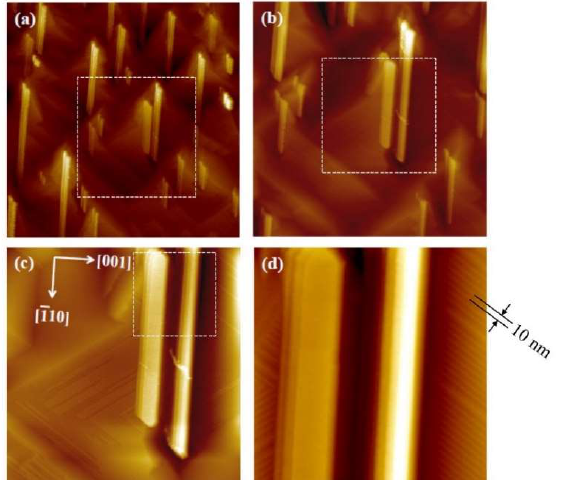
Figure 2. Spin-polarized scanning tunneling microscope (SP-STM) images of parallel Fe-silicide nanowires (NWs) on the Si(110)-16 × 2 surface taken at different magnifications: ( a ) 2 × 2 µ m 2 , ( b ) 1 × 1 µ m 2 , ( c ) 500 × 500 nm 2 , and ( d ) 200 × 200 nm 2 . All images were obtained at V b = 1.5 V and I t = 0.3 nA. The crystal directions are indicated in the figures. The magnified areas are indicated by the white dashed